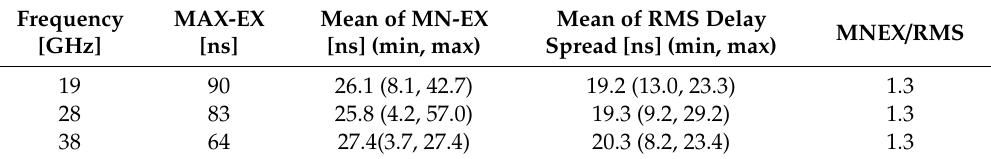
Figure 5. RMS delay spread (RMSDS) in the NLOS environment as a function of Tx–Rx separation. Table 3. Maximum excess delay; mean, minimum (min), and maximum (max) RMS delay spread; MN-EX delay; and mean/delay spread (MN/RMS) for the measured frequencies.